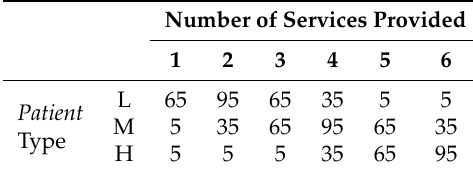
Table 1. Patient payoff probabilities in %.